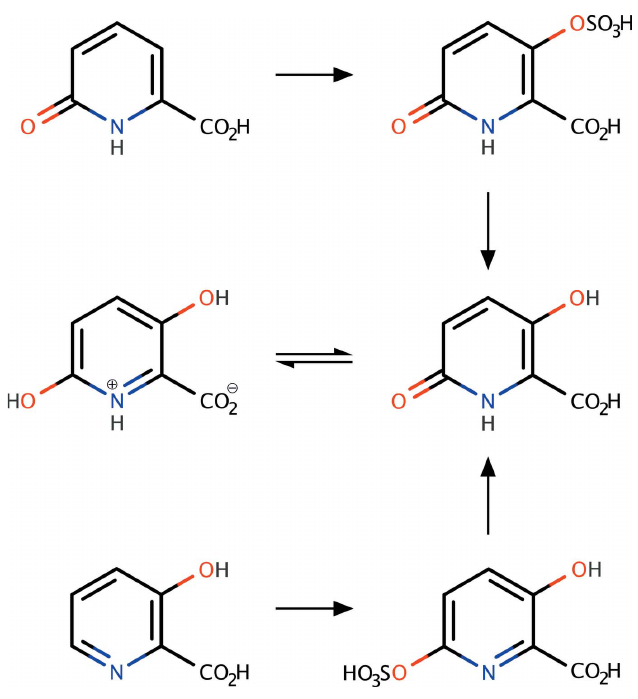
Figure 3 An ellipsoid (50% probability) plot of the asymmetric unit of I . The intramolecular hydrogen bond is shown by the thick dashed line. Dotted lines indicate close contacts of the K + cations.